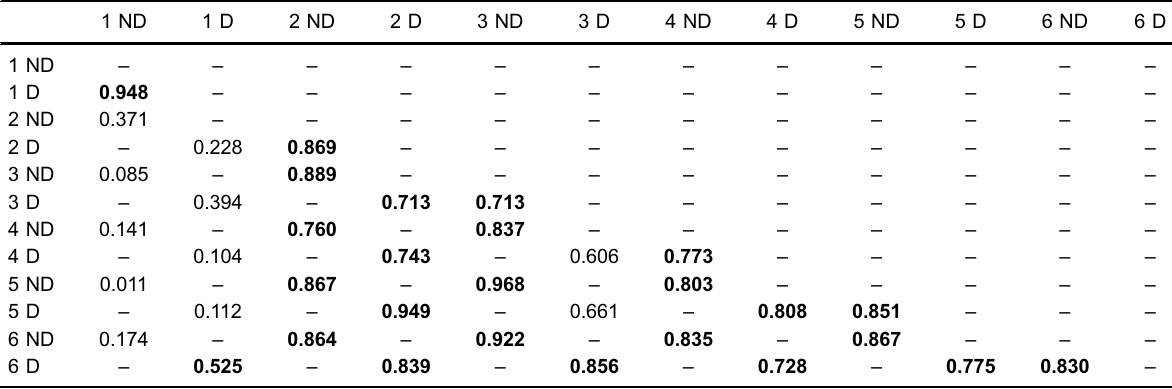
Table 3. Correlations between times of subtests of Jebsen-Taylor Test performed by dominant and non-dominant upper limbs. 1